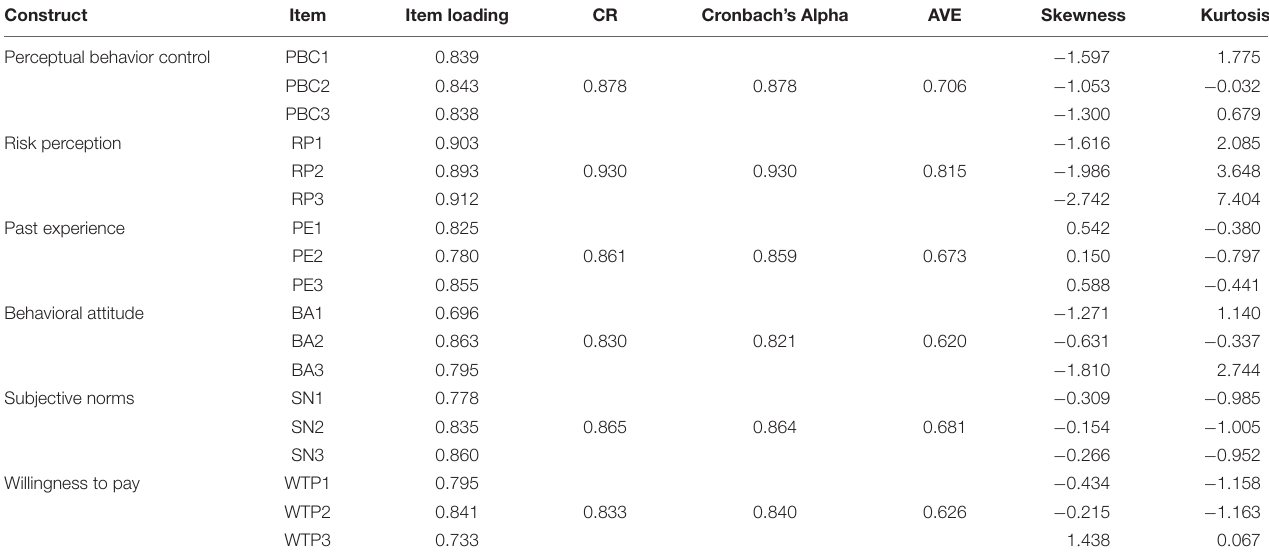
TABLE 3 | Reliability and convergent